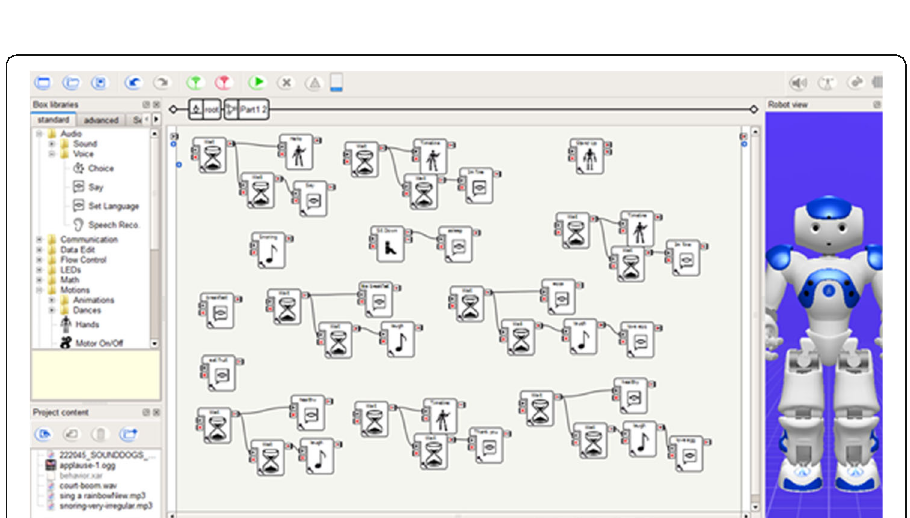
Fig. 7 A screenshot of the Choregraphe